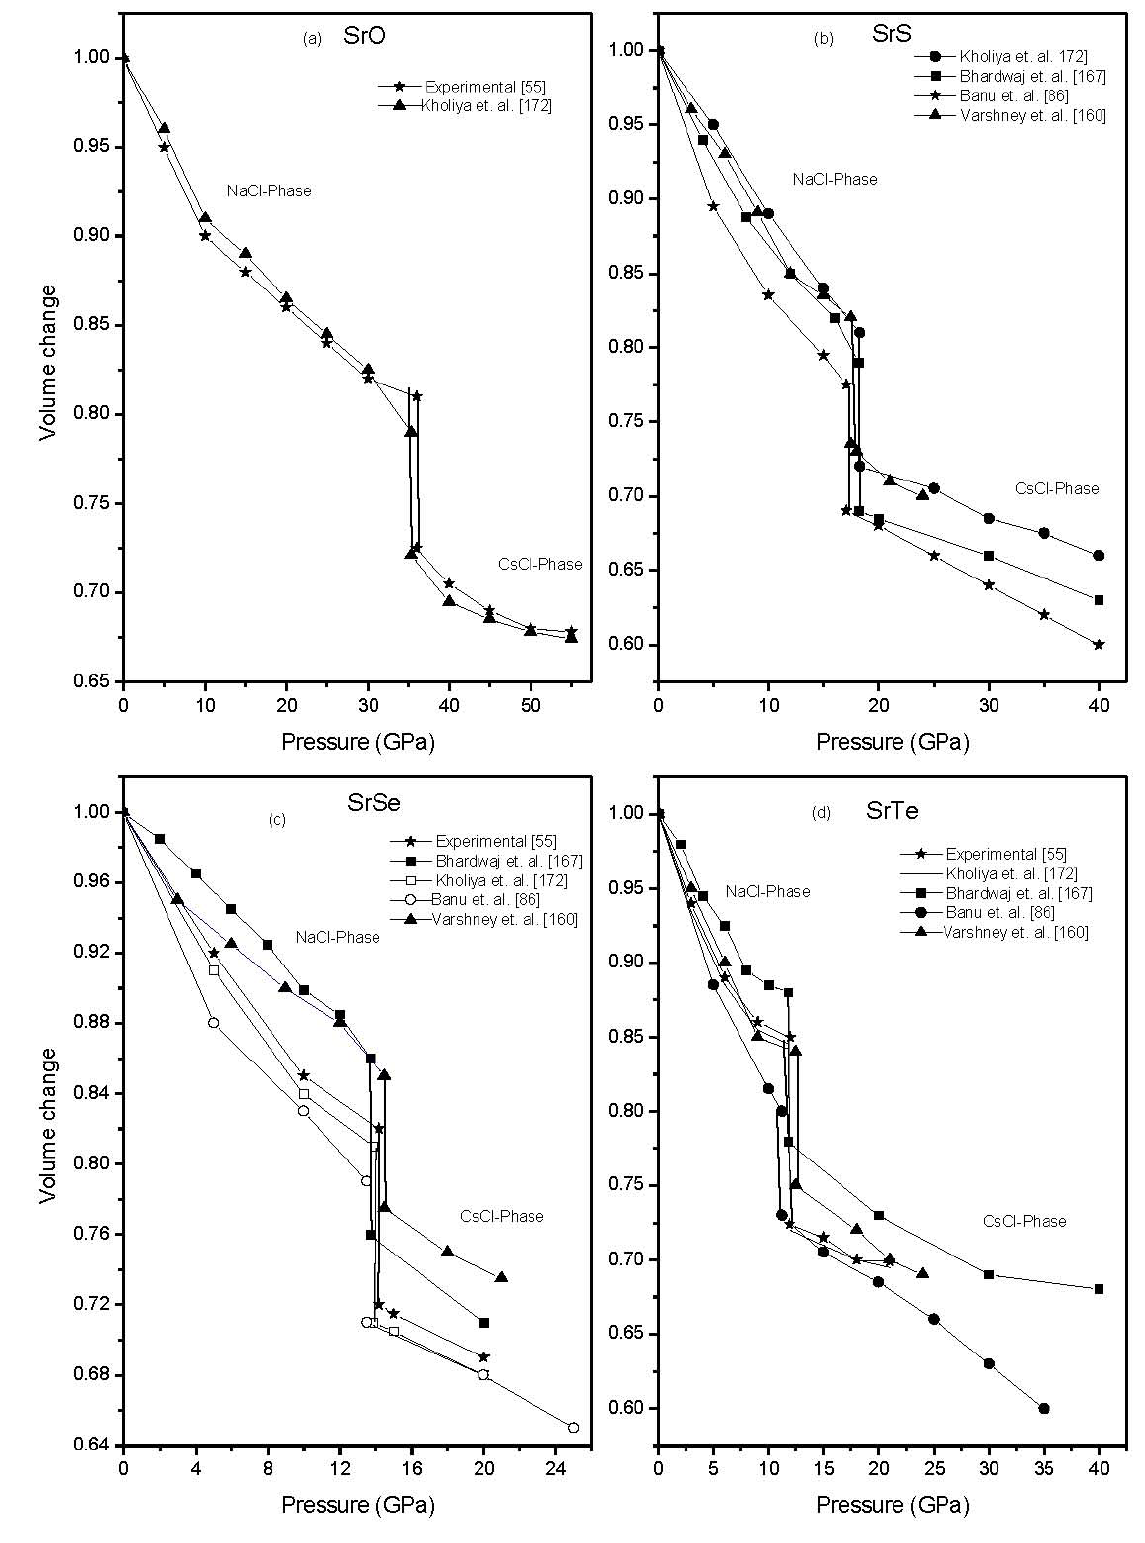
Figure 4. Variation of volume collapse with pressure for barium